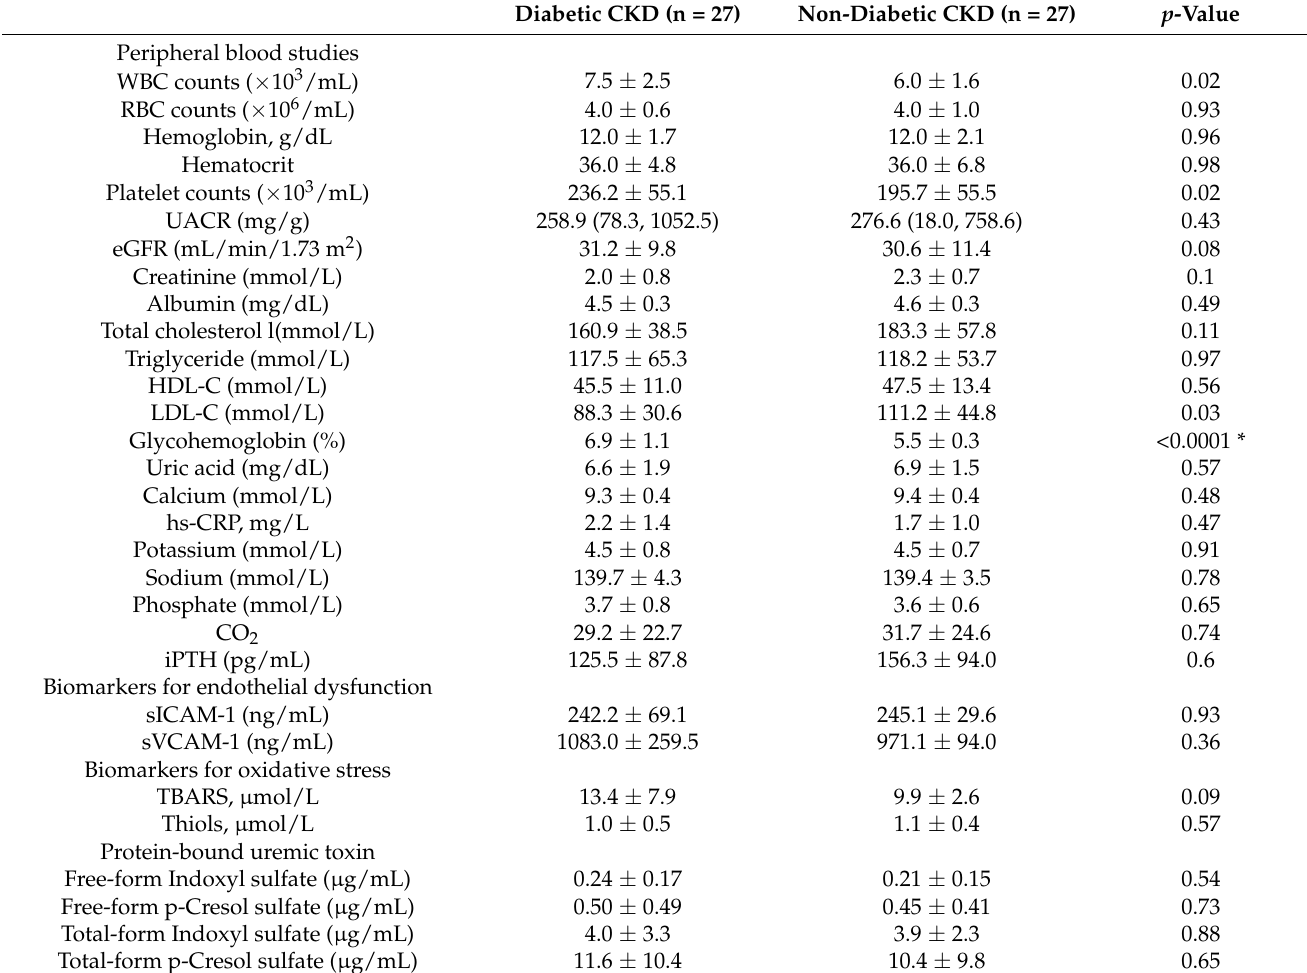
Table 2. Baseline biochemical data of patients with diabetic and non-diabetic chronic kidney diseases. Diabetic CKD (n = 27) Non-Diabetic CKD (n = 27) p